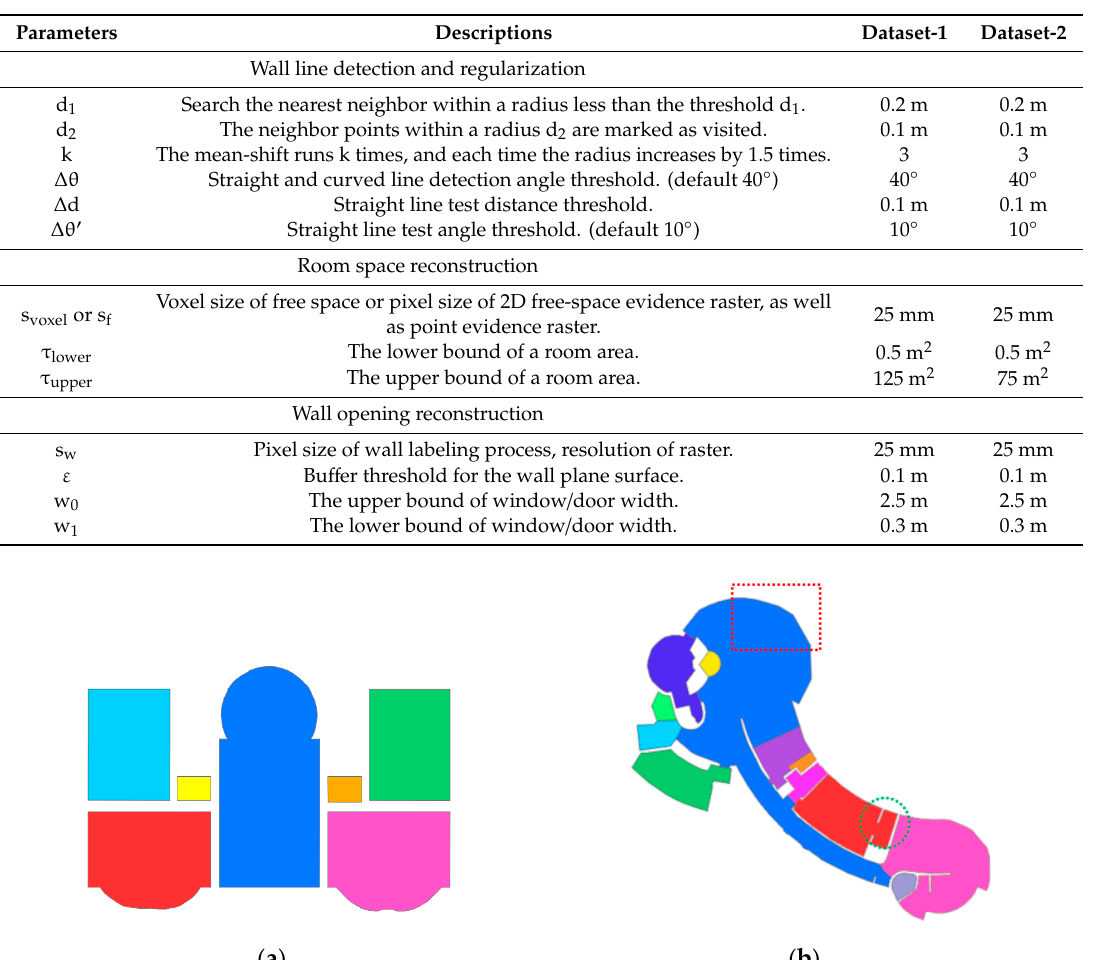
Table 1. Parameters of the proposed method for different datasets.